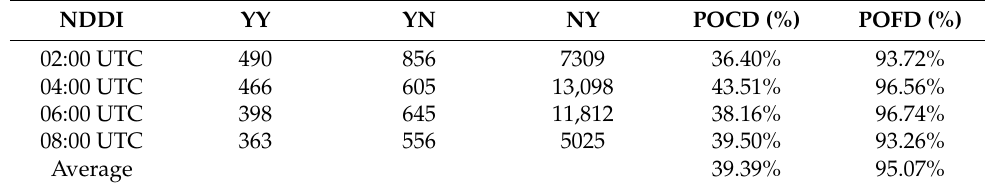
Table 4. Statistical metrics for the comparison of the NDDI dust identification and the PM10 observations.